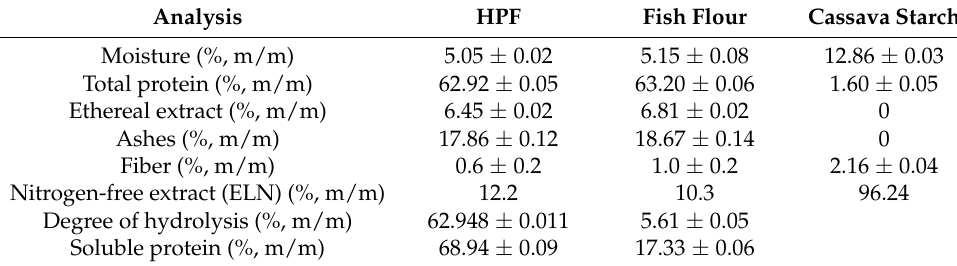
Table 1. Chemical composition of raw materials on a dry basis